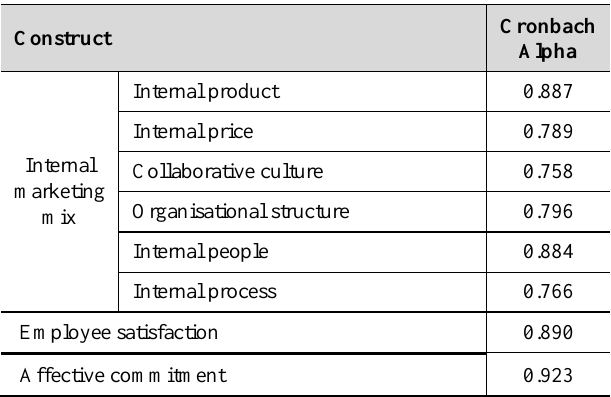
Table 1: Results of the Cronbach alpha test